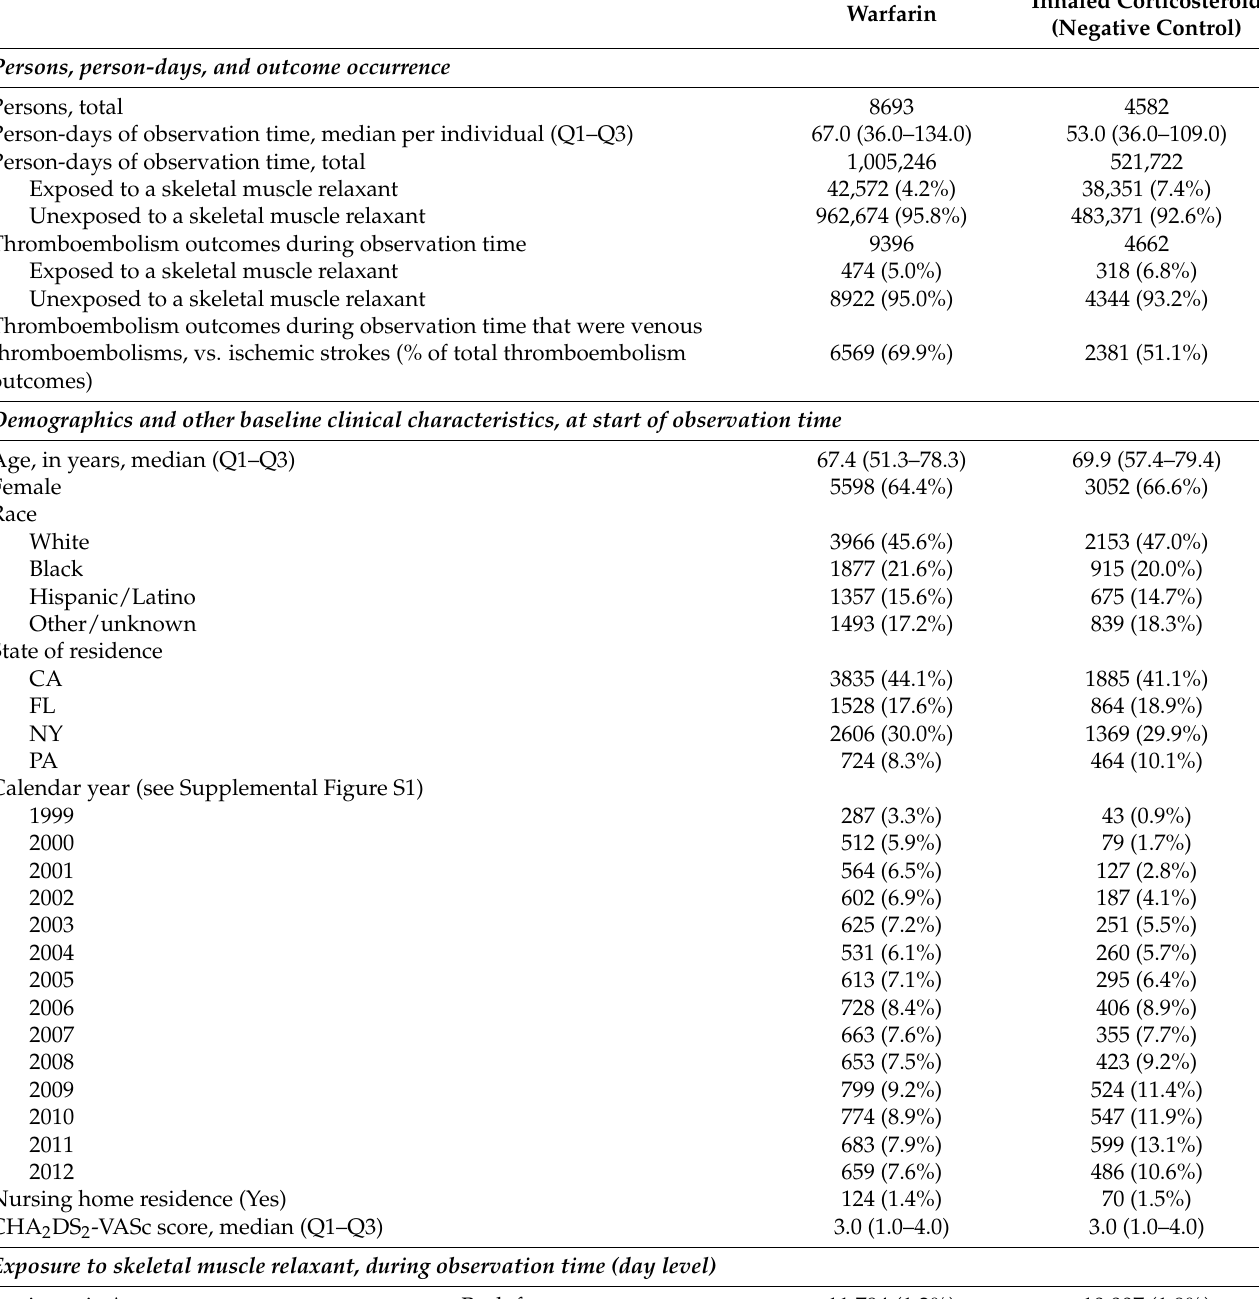
Table 1. Characteristics of persons under study who, by nature of the self-controlled study design, experienced at least one thromboembolic outcome during treatment with the object